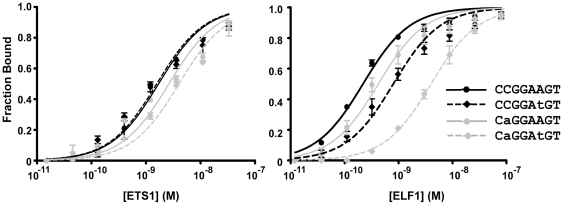
Intrinsic DNA binding affinity differences for ETS1 and ELF1.Full-length recombinant versions of the human ETS proteins ETS1 and ELF1 were purified from bacteria and assayed for affinity to radiolabeled oligonucleotides by gel-shift analysis. Datapoints represent the mean and standard error of the mean of two replicates for ETS1 and three replicates for ELF1. Each KD was derived by curve fitting by nonlinear least-squares analysis of equilibrium binding curves with fraction of DNA bound  = 1/(1+ KD/[ETS1]). The KD of ETS1 and ELF1 for the ETS consensus sequence was 1.7×10−9 and 1.7×10−10 M, respectively. The fold decrease in affinity due to the A to T change, the C to A change, and the combination of both changes were 1.0, 1.5, and 2.4 for ETS1 and 3.6, 1.9, and 18.3 for ELF1, respectively.